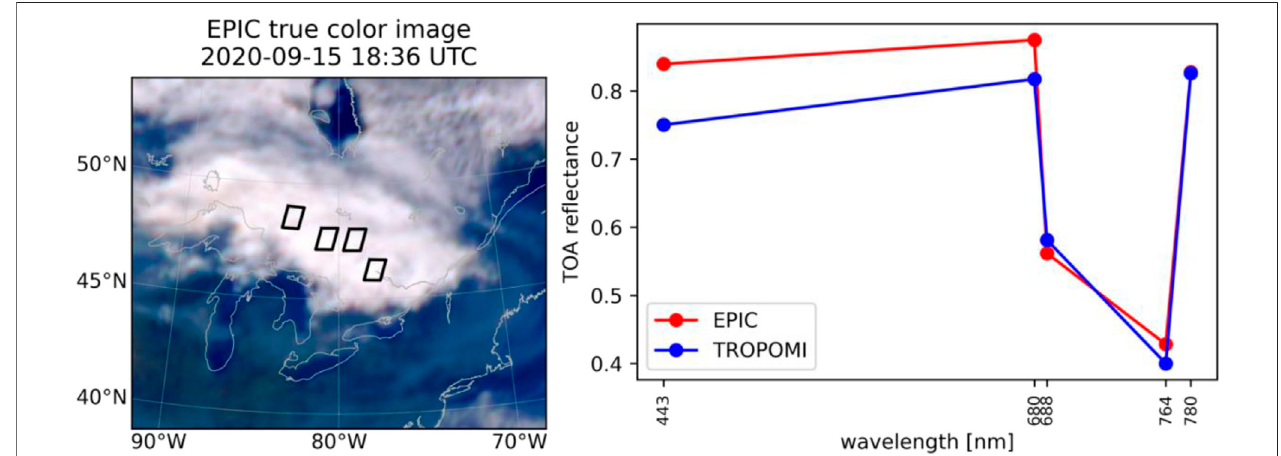
FIGURE 1 | Comparison of TOA re fl ectance from EPIC and TROPOMI. Four boxes (thick black polylines) with each box containing 10 × 10 pixels over a convective cloud in Eastern America on September 15, 2020, are selected for the comparison (left) . Mean TOA re fl ectance of 400 pixels from EPIC and TROPOMI at 443, 680, 764 and 780 nm are compared (right) . TROPOMI TOA re fl ectance values are convolved to EPIC narrow bands using the spectral response function ofEPIC. Evaluation of the AOD and AOCH retrievals.